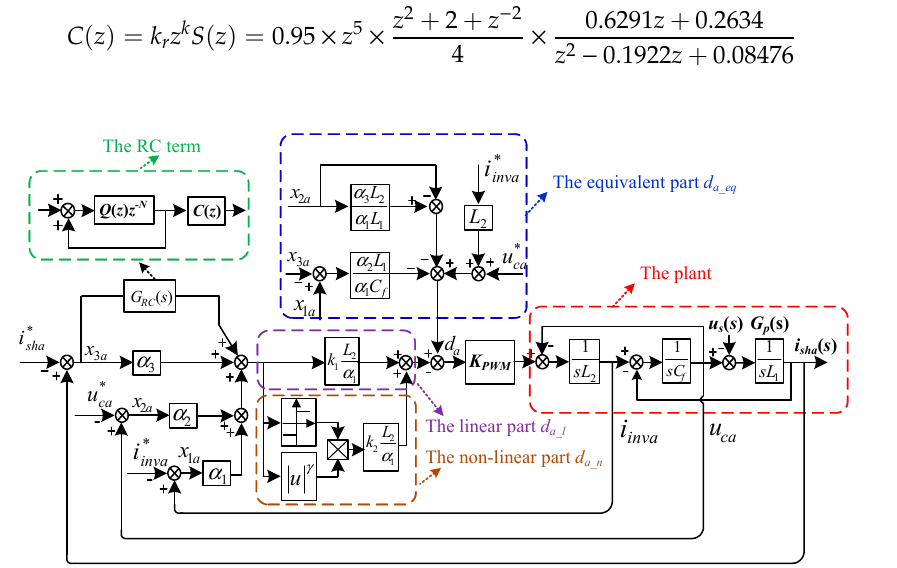
Figure 4. A-phase control block diagram of SAPF based on RCSMC.